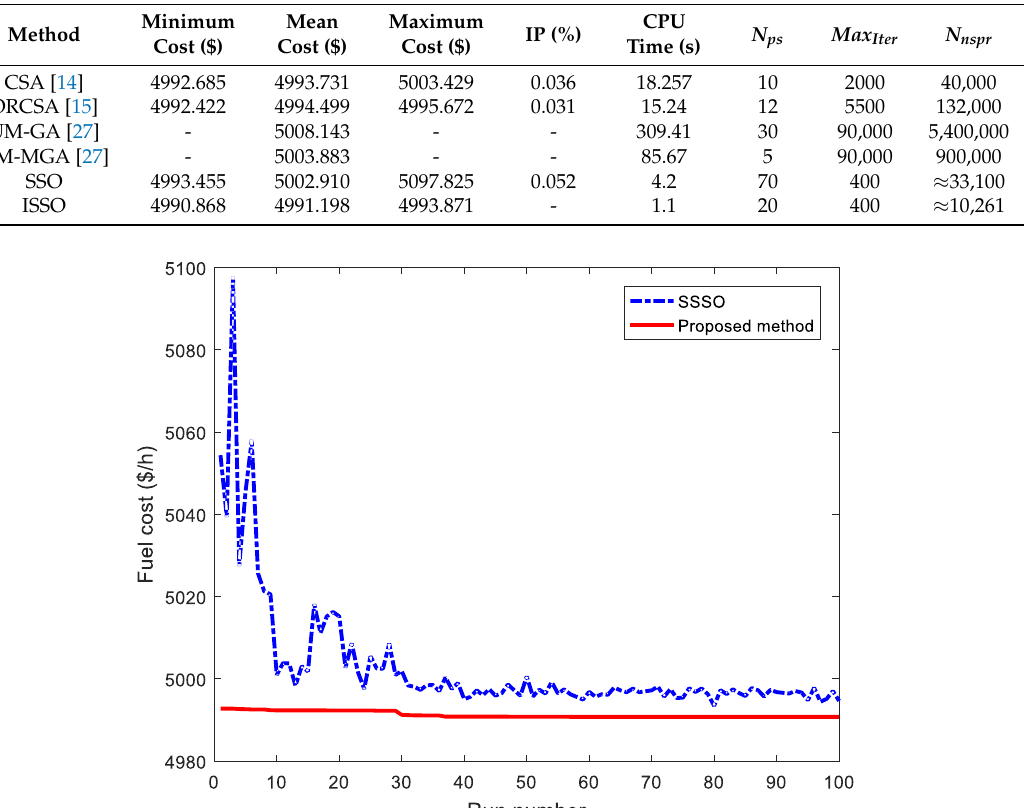
Table 7. Result summary obtained by different methods and the proposed method for system 4.